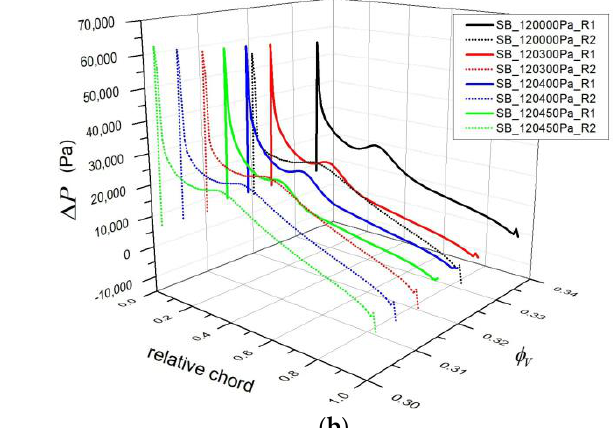
Figure 13. Load curve of blade-tip region under low-flow conditions in the S_B model. ( a ) Blade load and ( b ) blade load with volume flow.